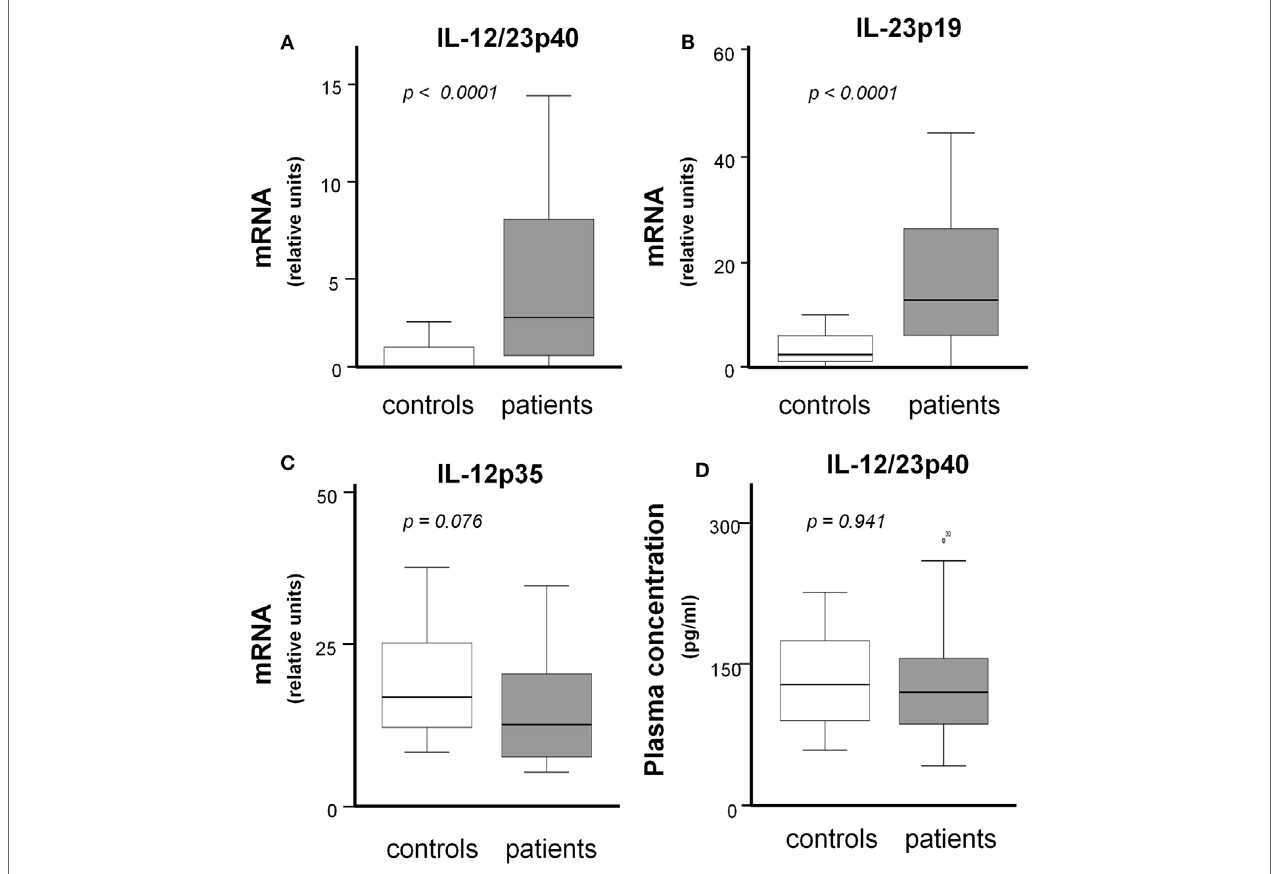
FigUre 1 | IL-12/23p40, IL-12p35, and IL-23p19 concentrations in temporal artery biopsies (mRNA) and in serum from patients with giant-cell arteritis (GCA). (a) IL-12/23p40 mRNA, (B) IL-23p19 mRNA, and (c) IL-12p35 mRNA expression (relative units) in temporal artery biopsies from 36 treatment-naïve patients and 20 controls. (D) IL-12/23p40 concentration in sera from 36 treatment-naïve patients and 19